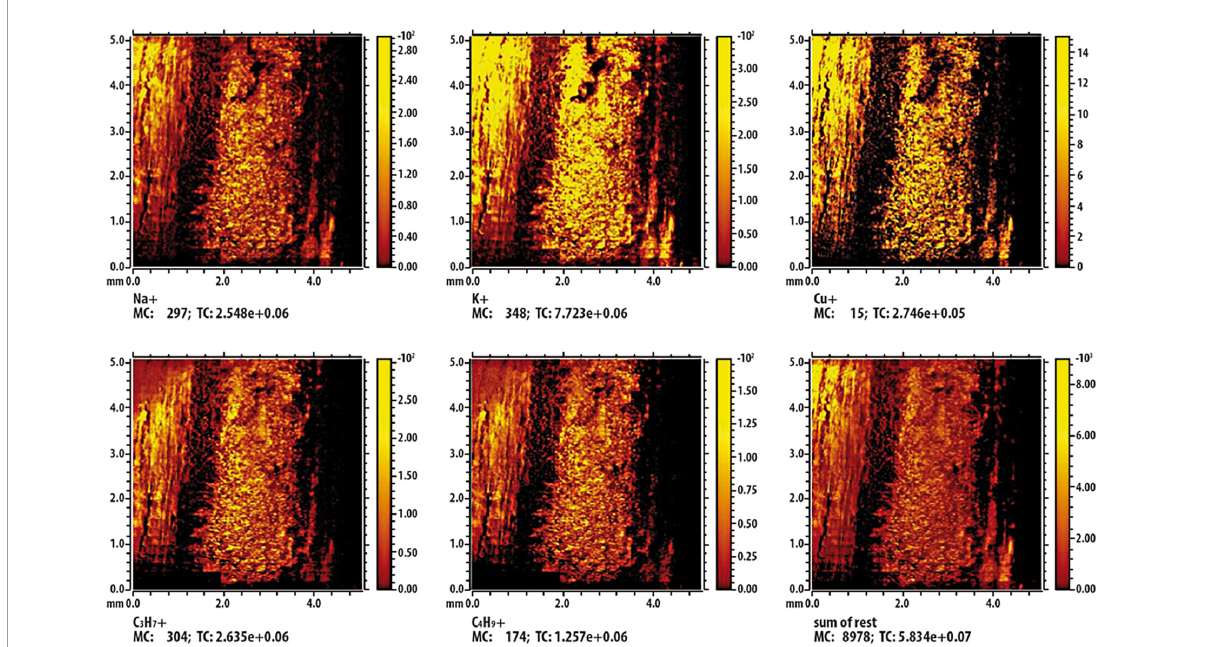
FIGURE9 Time-of-flight secondary ion mass spectrometry (ToF-SIMS) false-color image of some characteristic ions on the surface of the twig section immersed in a copper solution. The inset labeled “sum of rest” represents the sum of the other signals present in the spectrum but not shown in the